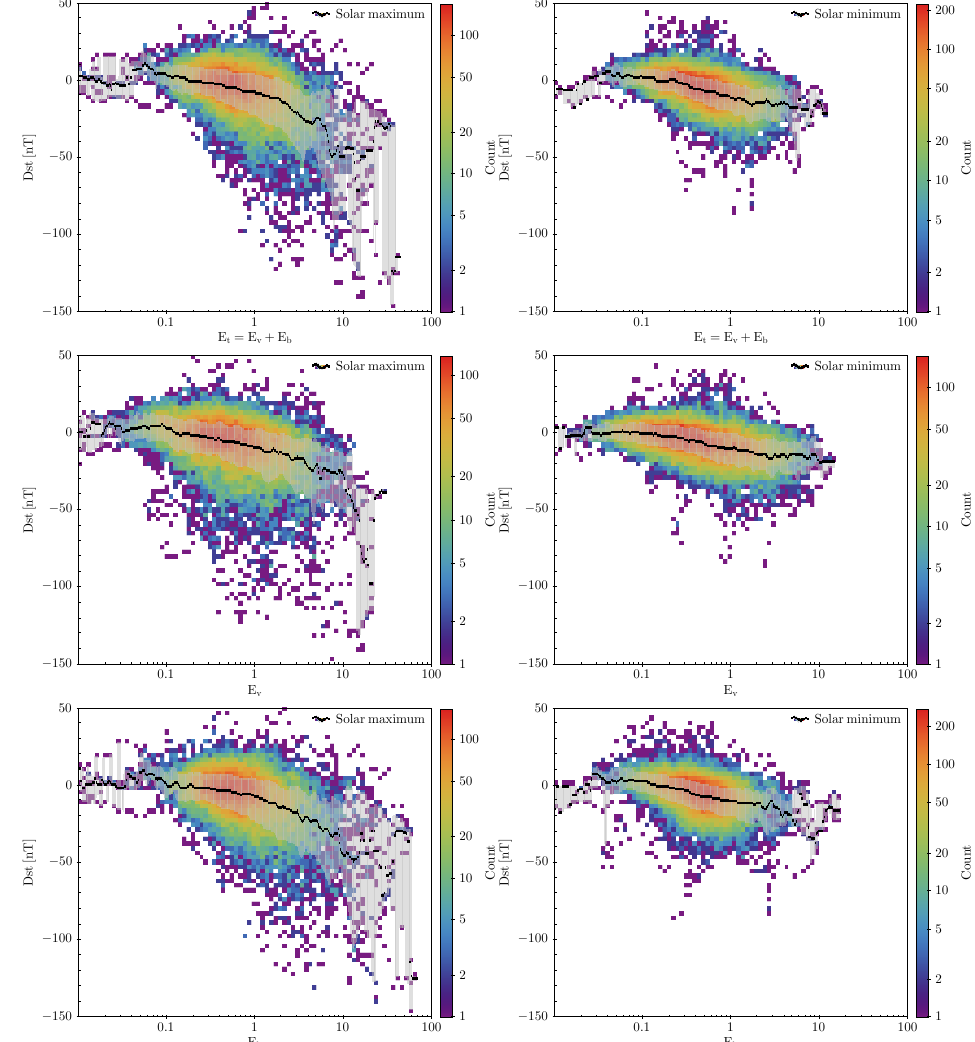
Figure 3. Bivariate histograms of the Dst index measurements as a function of the SW energy total energy ( first row ), kinetic energy ( second row ), magnetic energy ( third row ), respectively, for maximum ( left column ) and minimum ( right column ) solar activity periods. The black solid line represents the most probable Dst value at each energy level, within the 68% confidence bounds indicated by the shaded gray